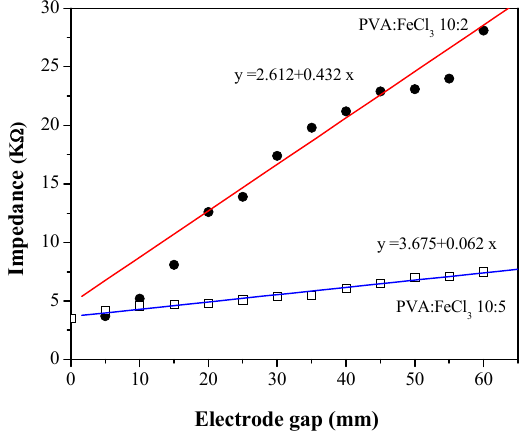
Figure 8. Impedance versus electrode separation on the surface of samples C and